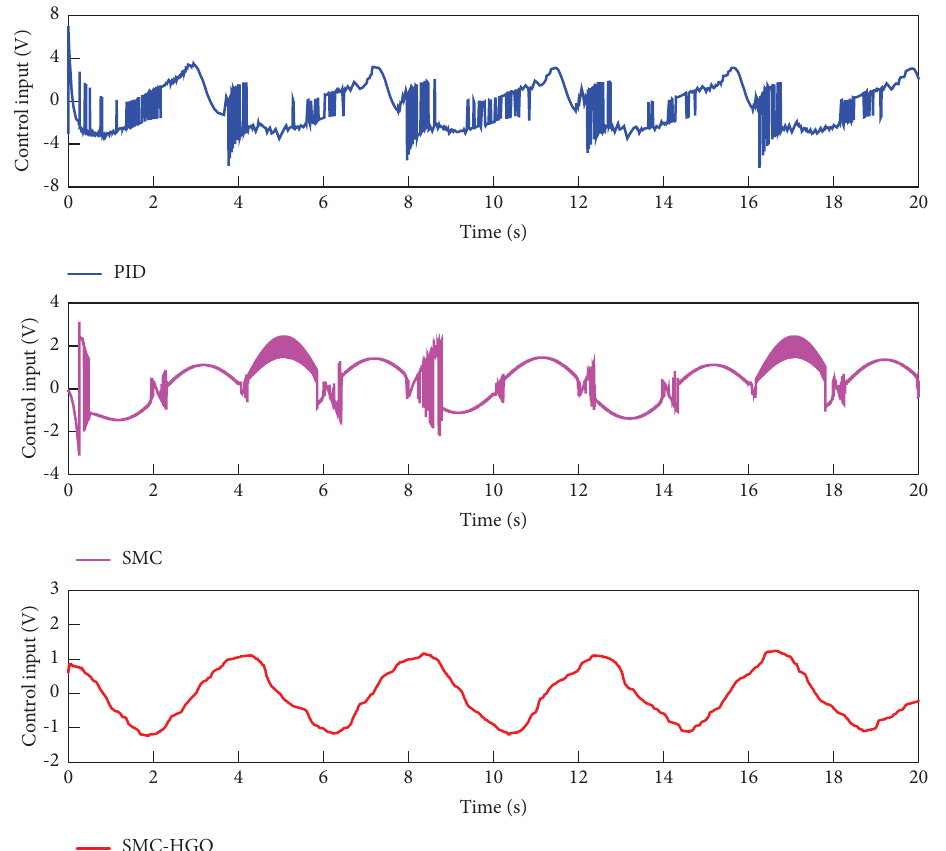
Figure 10: Control inputs of multifrequency sinusoidal